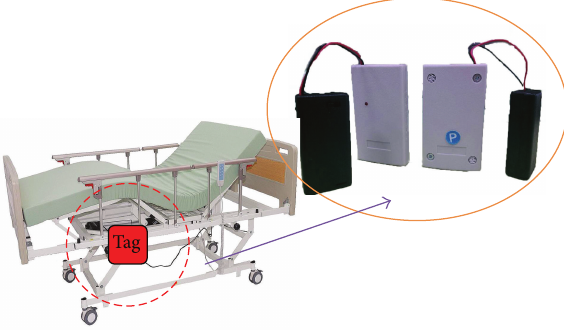
Figure 2: The placement of a tag on a hospital